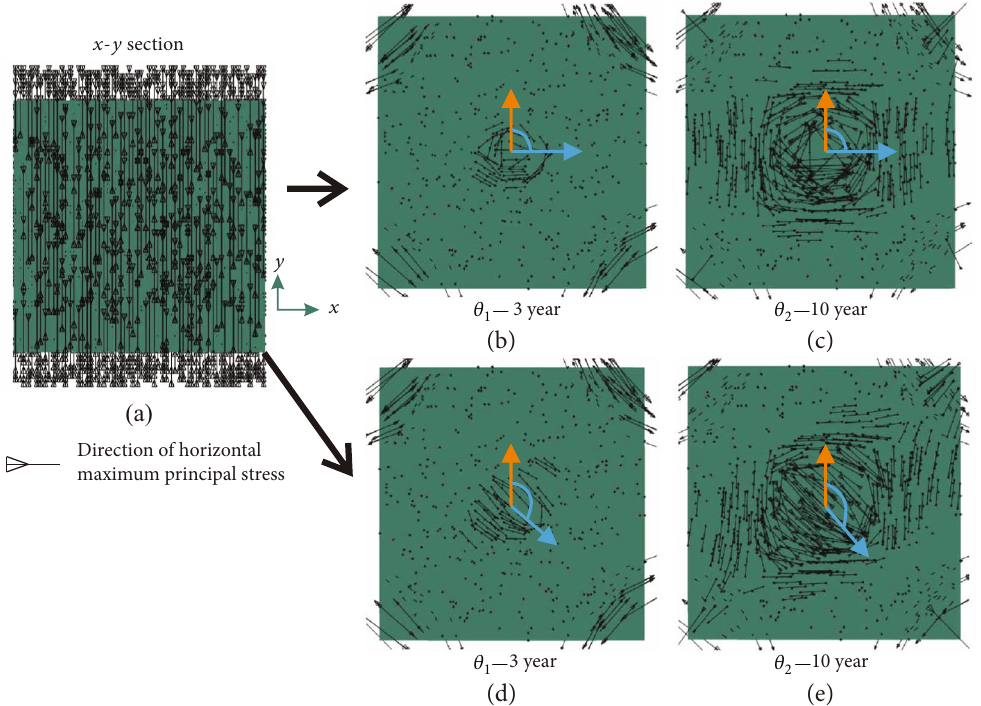
Figure 19: (a) presents the direction of the initial maximum horizontal principal stress on the x - y section. (b) and (c) present the direction of the maximum horizontal principal stress after 3 years of depletion without considering the natural cracks. (d) and (e) present the direction of the maximum horizontal principal stress after 10 years of production considering the natural cracks.